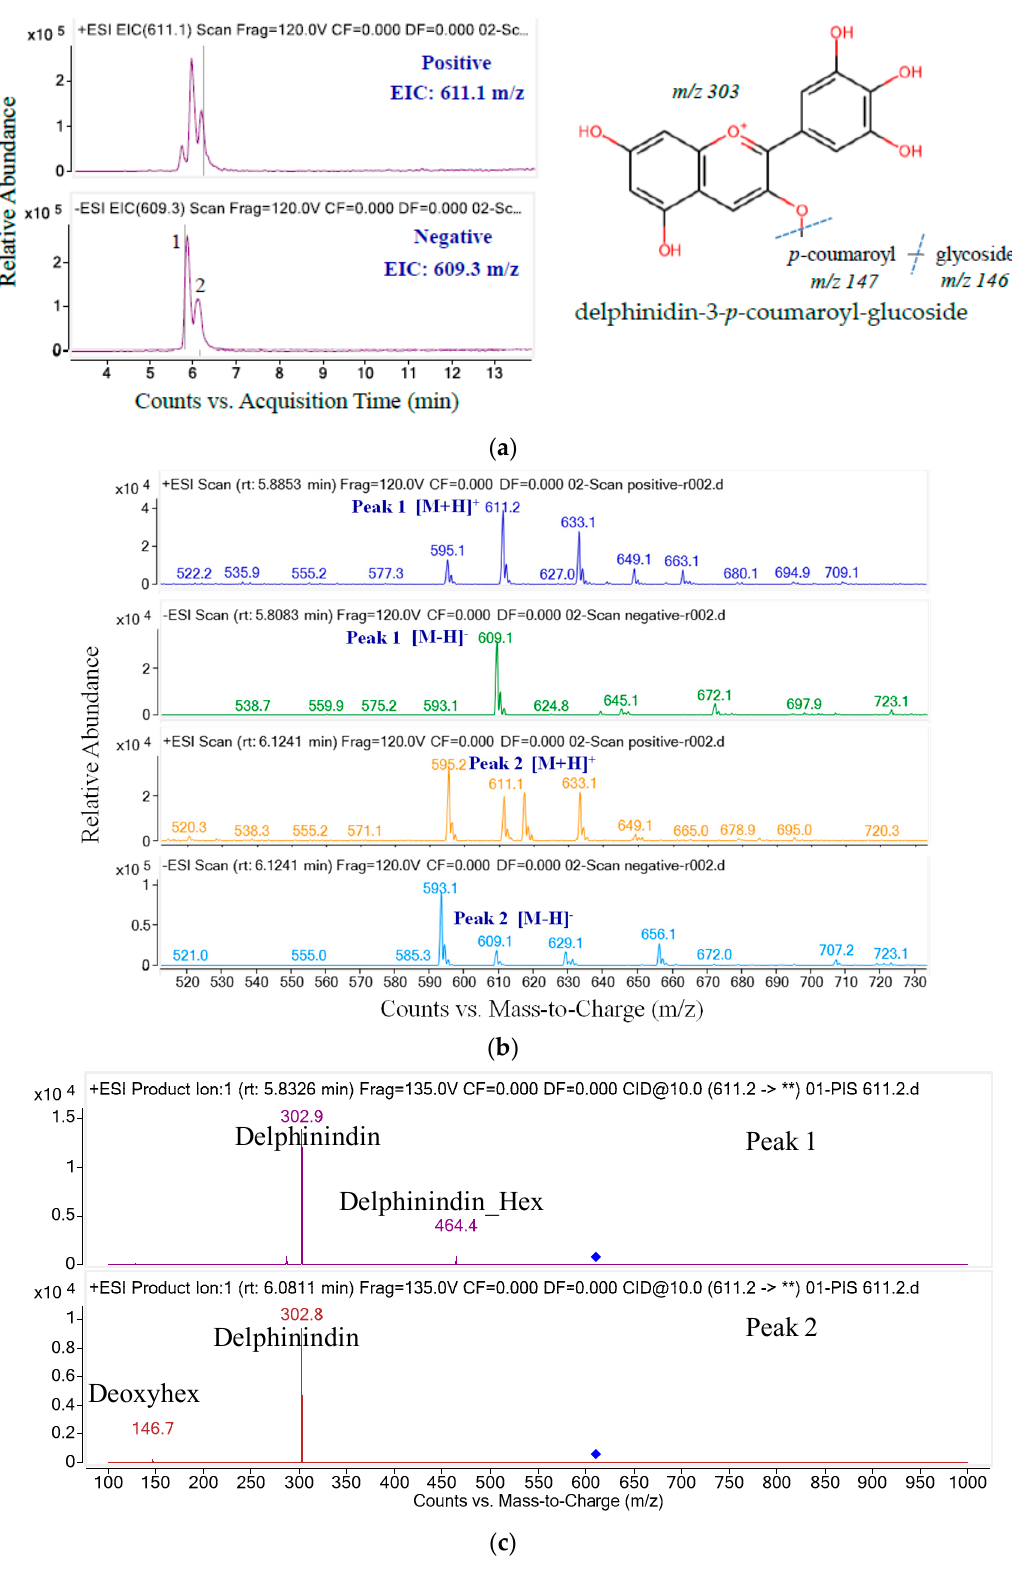
Figure 5. The ion chromatograms ( a ) and ion spectra ( b ) and MS/MS fragments (**) of parent mass 611.2 ( c ).